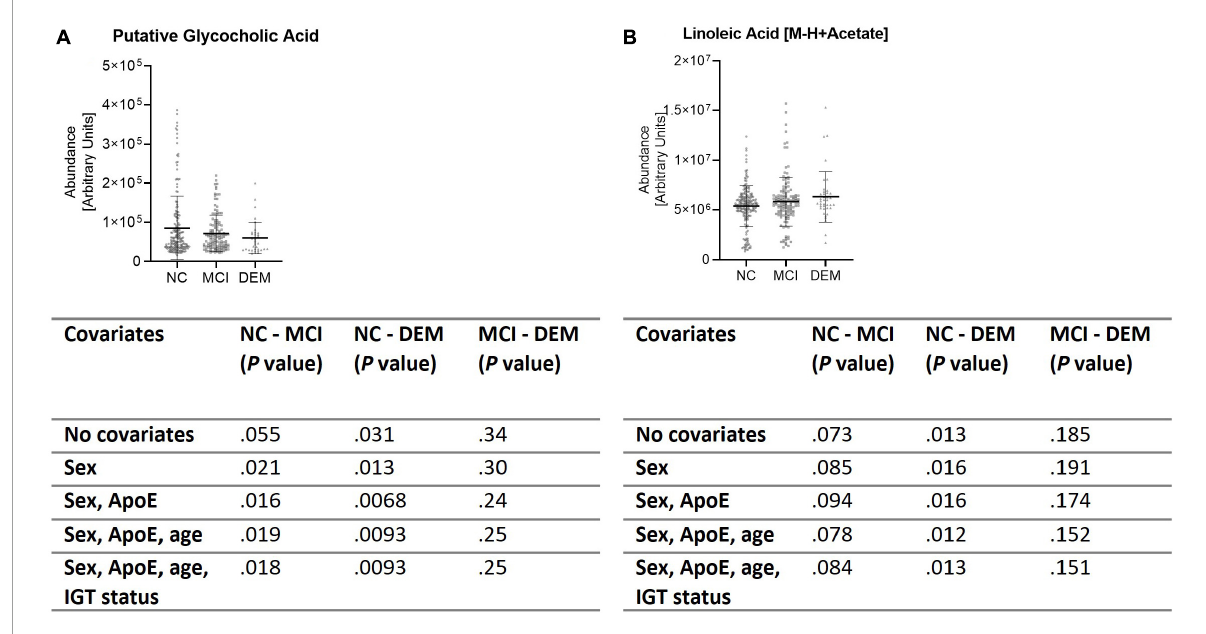
FIGURE5 Validation cohort shows same differences in lipid abundance across cognitive groups. (A,B) Lipid candidates’ abundance by cognitive group for validation cohort ( n = 365) and P- values for differences between groups when controlled for sex, ApoE status, age, and IGT